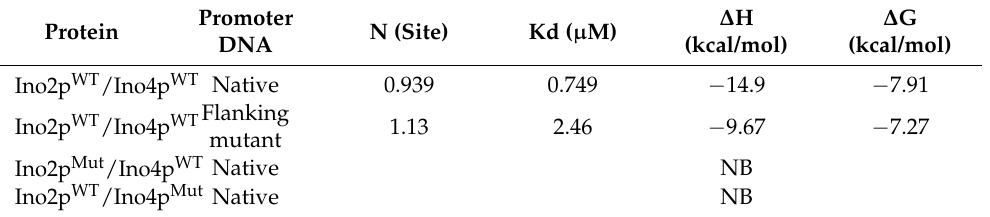
Table 2. Binding energetics parameters of Ino2p DBD /Ino4p DBD against the promoter DNA fragment.